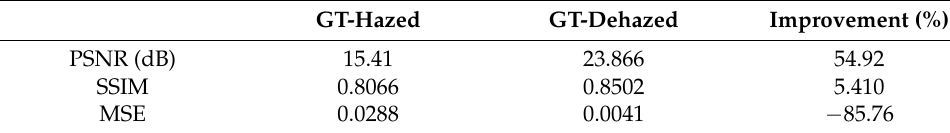
Table 3. Quantitative analysis of improvement using third row image from Figure